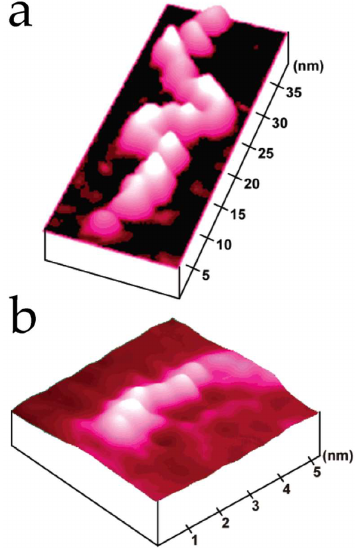
Figure 8. STM images of molecular necklaces, where ( a ) is a necklace of 22 α-CyDs and ( b ) one of 15 α-CyDs. Reprinted with permission from Ref. [100] . Copyright (2003), American Chemical Society.